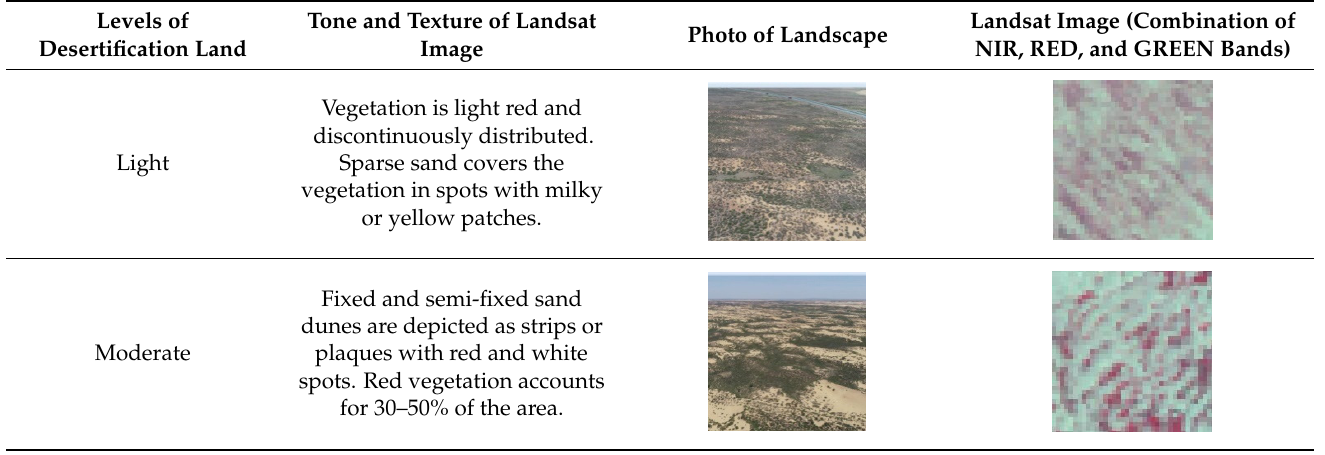
Table A2. Interpretation signs and characteristics of desertification land.